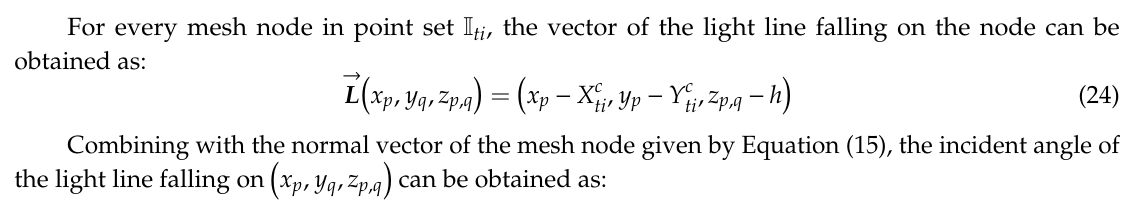
Figure 7. The incident angles of the laser light in a laser beam.